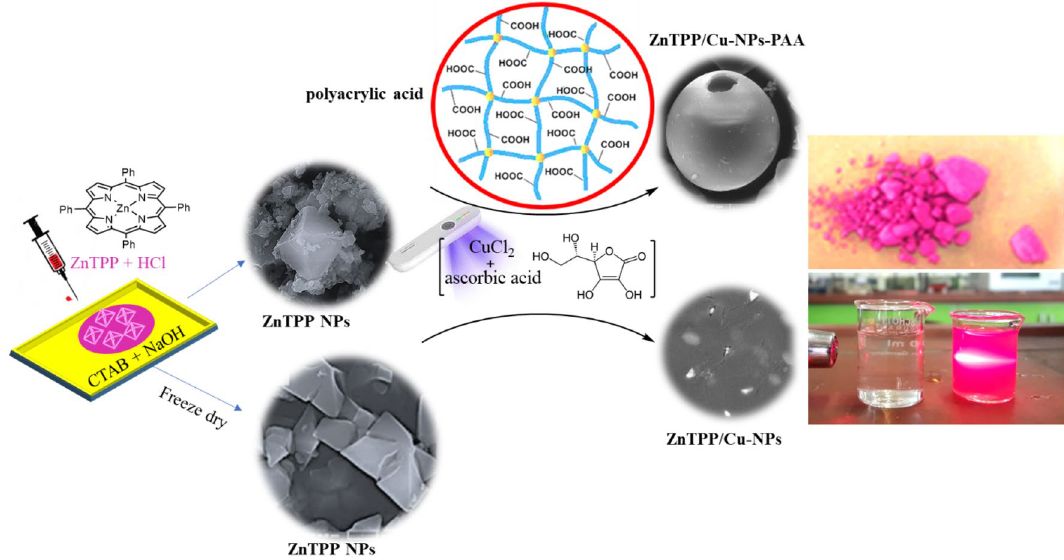
Figure 1. The schematic illustration of ZnTPP, ZnTPP-NPs, ZnTPP/Cu-NPs and ZnTPP/Cu-NPs-PAA